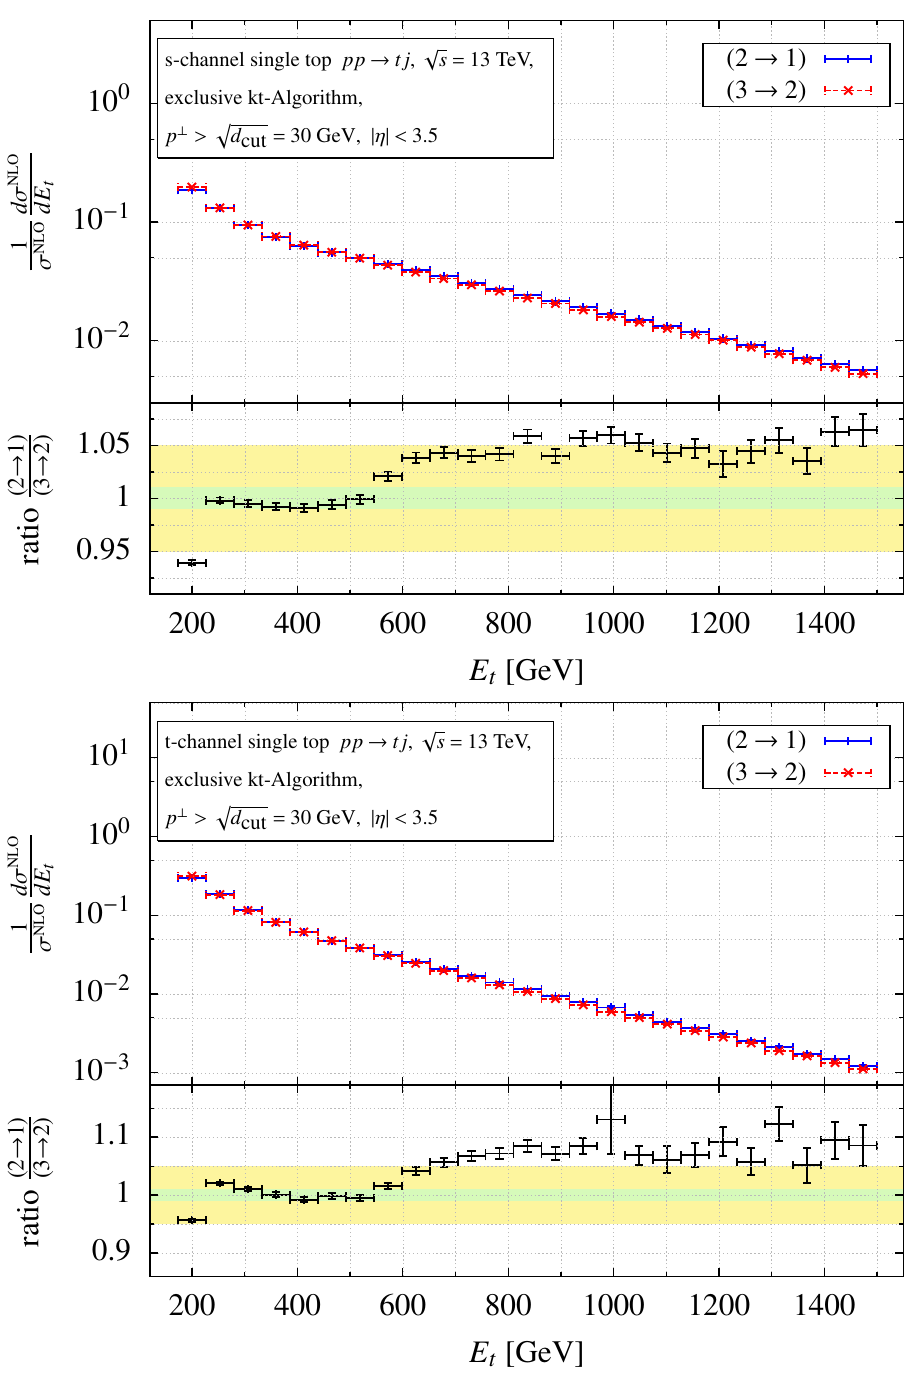
Figure 21 . Energy distributions of the top-tagged jet from s - and t -channel single top-quark production at NLO with 3 ! 2 (red, dashed) and 2 ! 1 (blue, solid) jet clusterings.